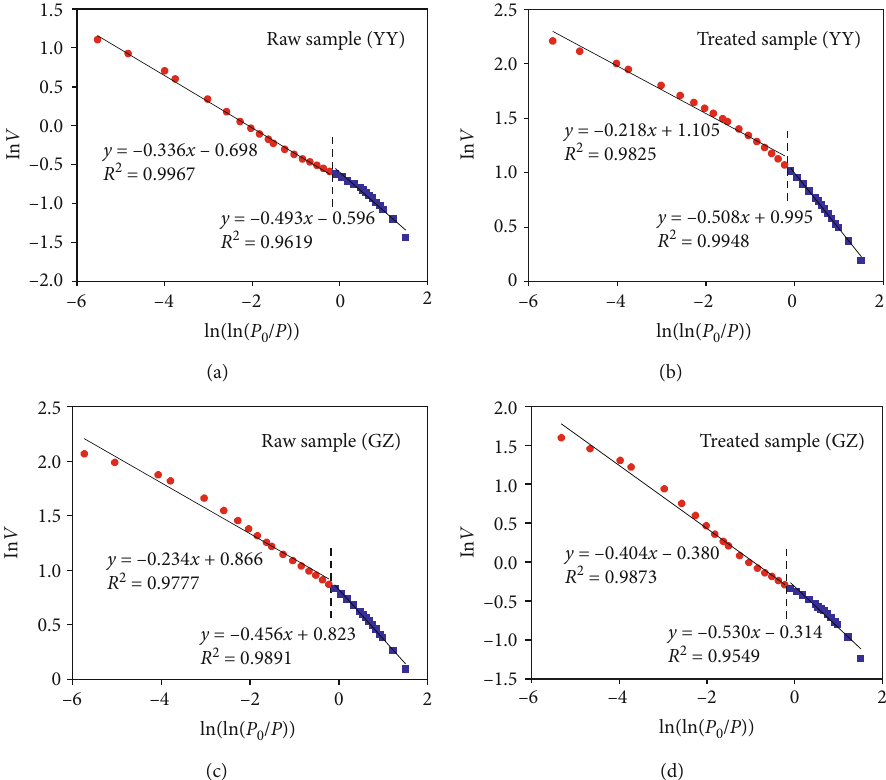
Figure 8: Plots of ln ð V Þ versus ln ð ln ð P treatment: (a, b) YY; (c, d)